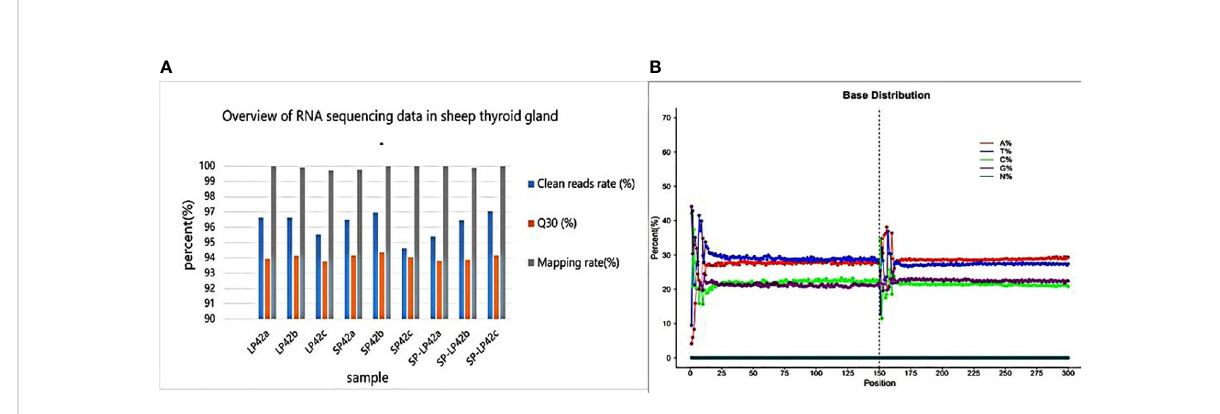
FIGURE 1 Overview of RNA sequencing data in thyroid glands. (A) Clean read rate, Q30 and mapping rate in sheep thyroid gland. (B) Base distribution of